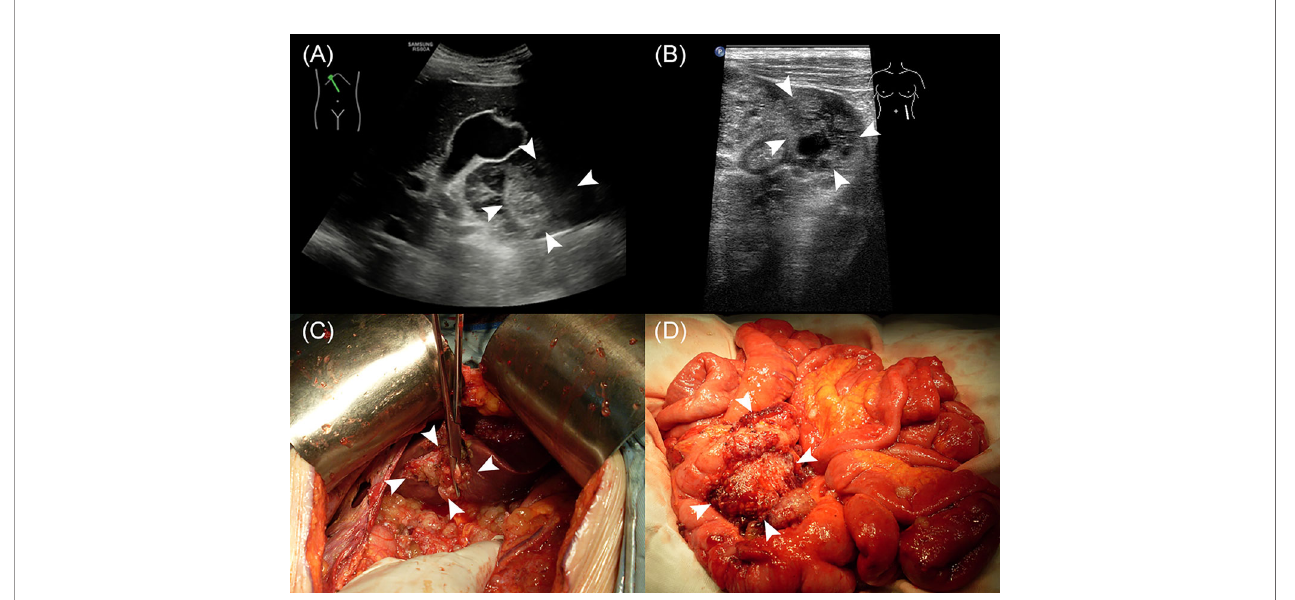
FIGURE 2 | The US characteristics and the corresponding gross specimens of PMP patients. (A, C) Portal in fi ltration. (B, D) Mesenteric involvement.